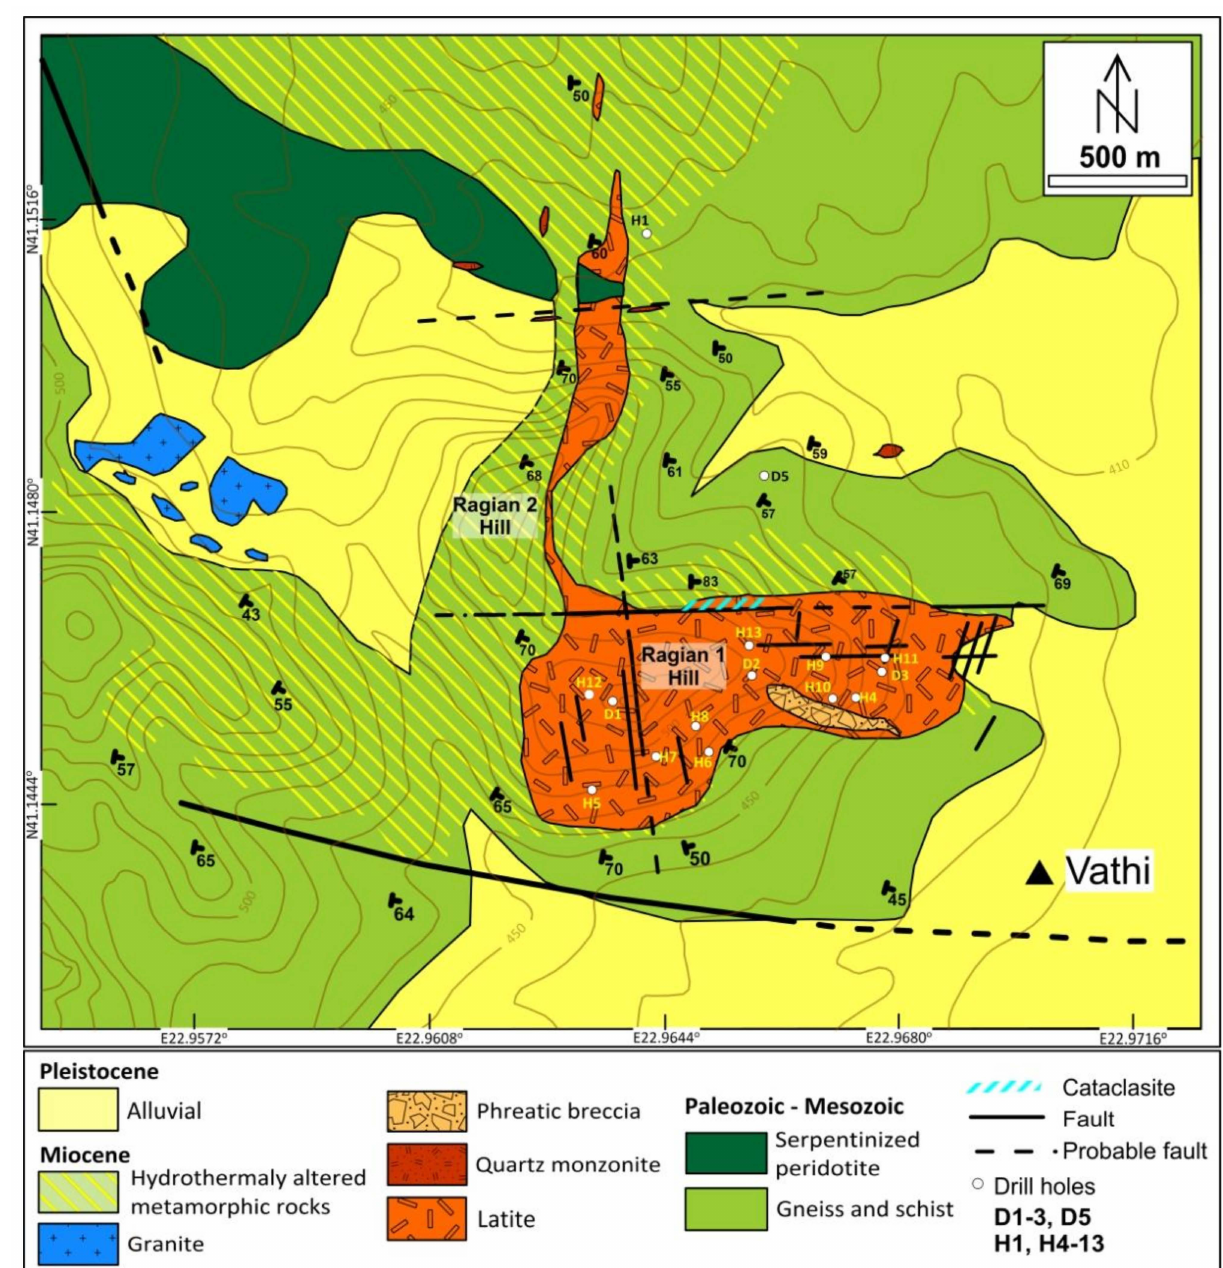
Figure 2. Geological map of the Vathi porphyry system. The legacy drill holes are also shown (modified after